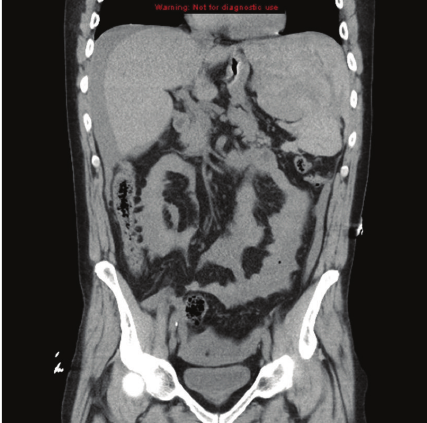
Figure 2: Coronal view. Patient’s Hgb had dropped from 12.3 to 8.7 g/dL at this